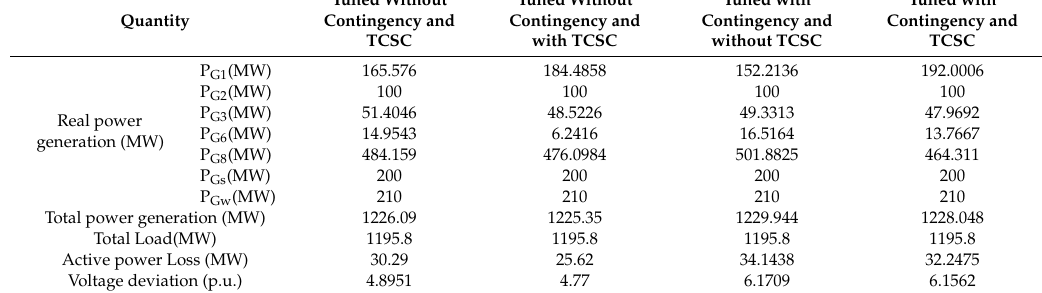
Figure 7. Box plot for fused severity index values for various line outages. Table 8. Different parameters for the IEEE57bus system using the grey wolf algorithm.